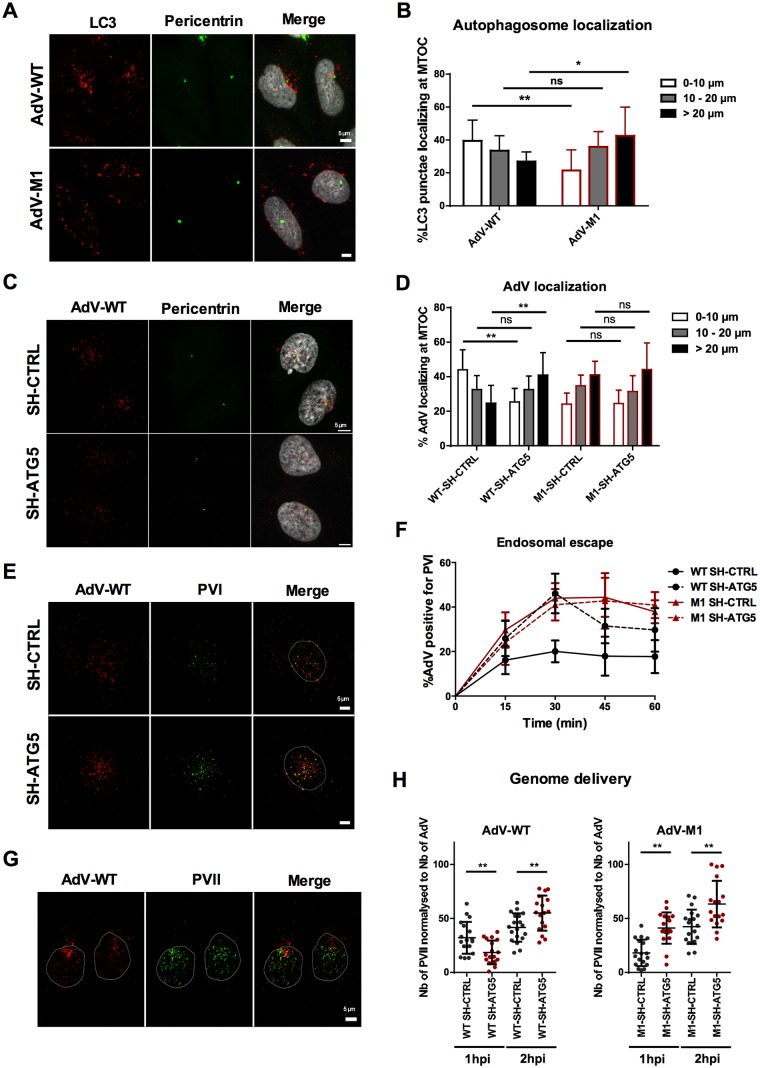
Nuclear transport of AdV involves the autophagic machinery.(A) Representative panel of WT or M1 infected cells at 1hpi stained with LC3 (red signal) and pericentrin (green signal) specific antibodies. (B) Quantification of the relative distribution of autophagosomes for experiment shown in (A) essentially analyzed as described for Fig 9E. (n>12 cells; NS: no significant; *: P<0.05; **: P<0.01) (C) Representative panel of WT infected cells at 1hpi depleted for ATG5 or control depleted (as indicated) and stained with AdV (red signal) and pericentrin (green signal) specific antibodies. (D) Quantification of the relative virus distribution as in (B) for the experiment shown in (C) including the distribution of M1 and WT viruses. (n>12 cells; NS: no significant, **: P<0.01) (E) Representative panel of WT infected cells at 1hpi depleted for ATG5 or control depleted (as indicated) and stained with AdV (red signal) and PVI (green signal) specific antibodies to mark PVI separation from the virus. (F) Infection time course analysis of PVI release from M1 (red line) vs. WT (black line) viruses in ATG5 depleted (dotted line) vs. control depleted cells (solid line). Shown is the percentage of PVI positive AdV at indicated time points. The errors bars are cell-to-cell variation (10 cells were analyzed for each conditions). (G) Representative panel of WT infected cells at 1hpi and stained with specific antibodies against AdV (red signal) and specific antibodies against PVII (green signal) to mark nuclear genomes. (H) Quantification of nuclear genome delivery. ATG5 and control depleted cells were infected with WT and M1 and fixed at 1 and 2hpi and stained for AdV and PVII. The number of nuclear PVII dots was calculated and normalized for virus particles at each condition as indicated below the graph (n>16 cells; **: P<0.01; ***: P<0.0001). (See also S7 Fig).